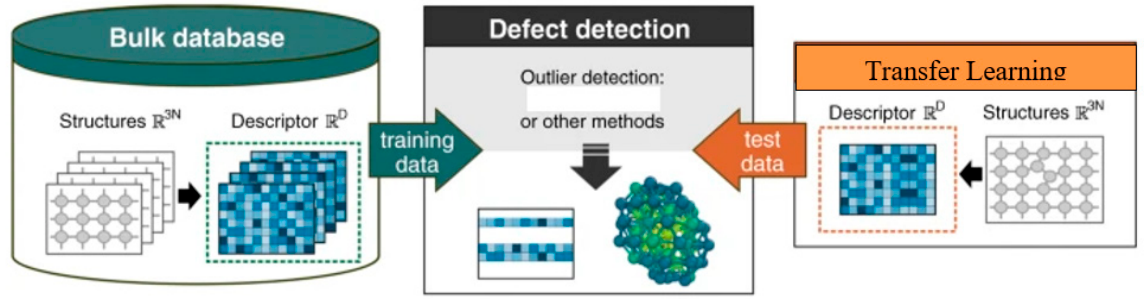
Figure 4. Transfer Learning Model.